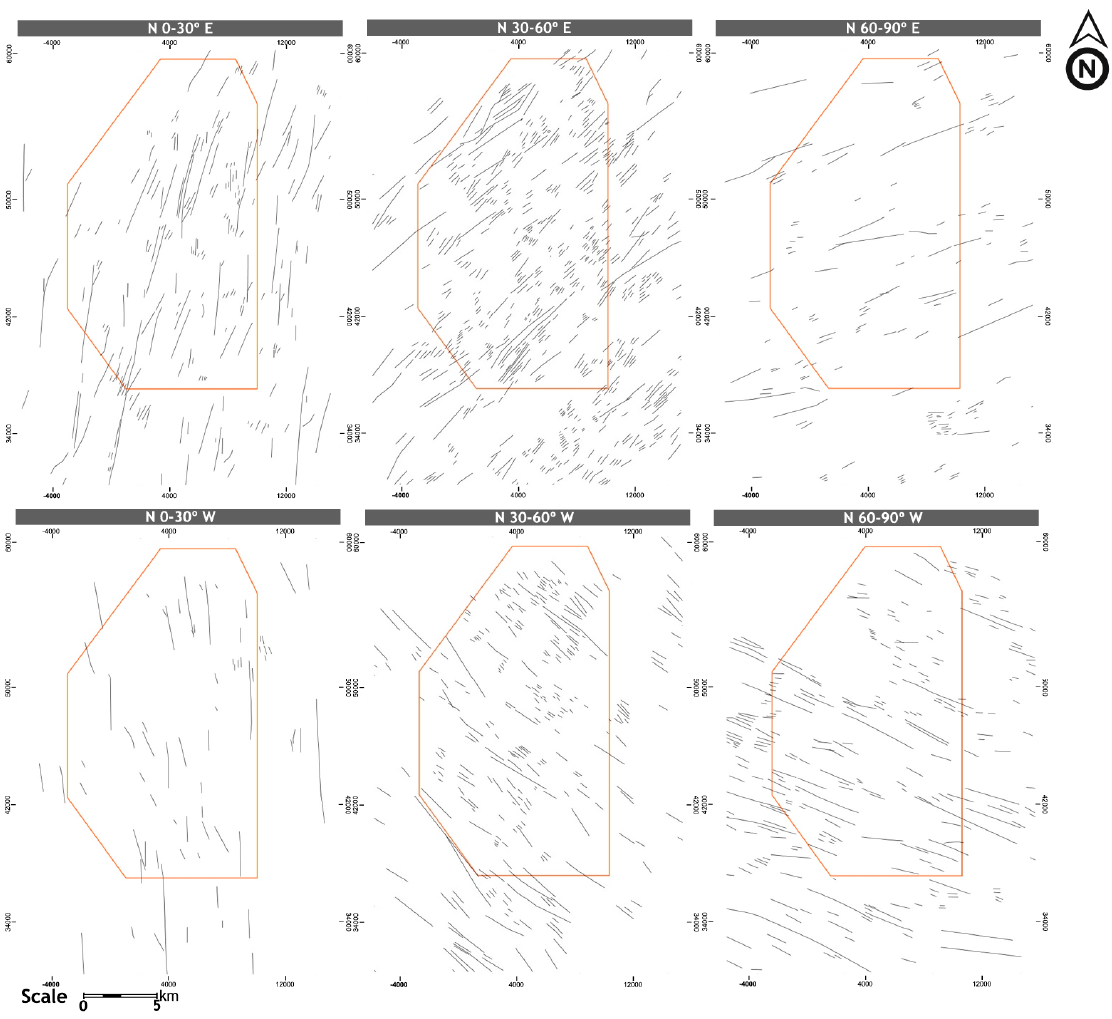
Figure 15. Lineament maps grouped according to their trend, in classes of 30°.